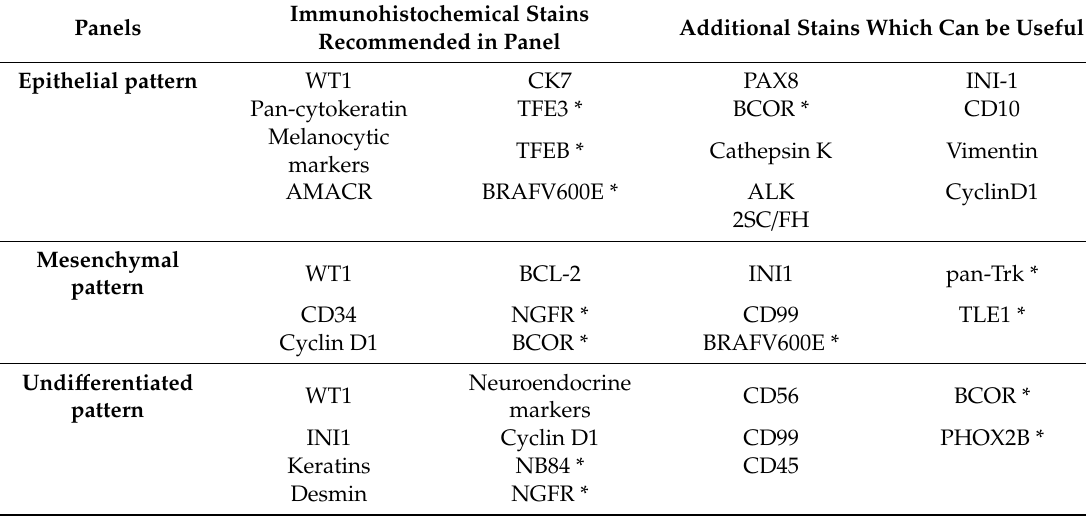
Table 6. Recommended immunohistochemical panels in the di ff erential diagnosis of pediatric renal